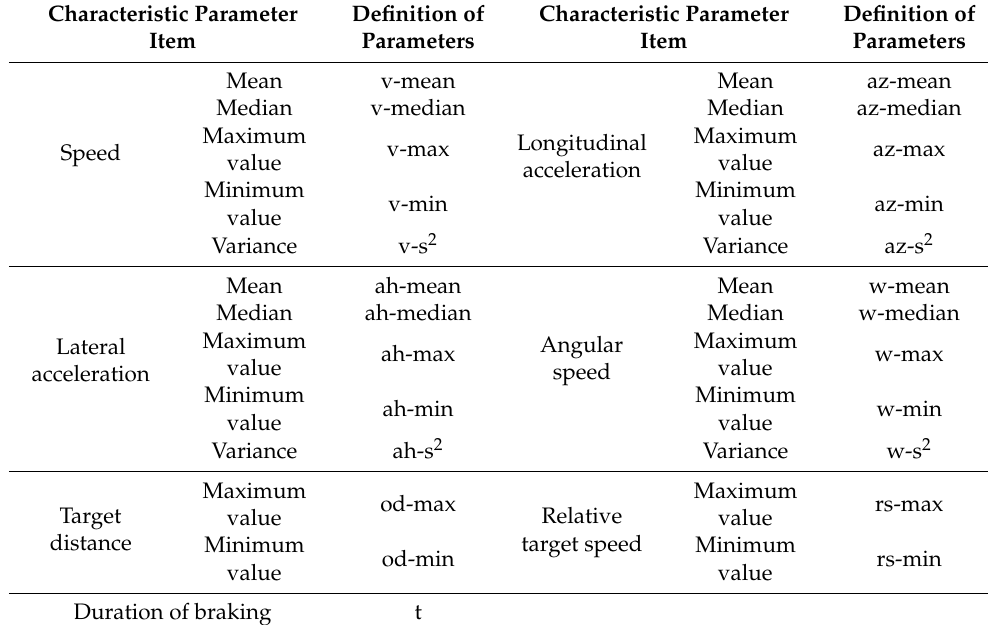
Table 2. List of characteristic parameters of the truck drivers’ braking behavior segment. Characteristic